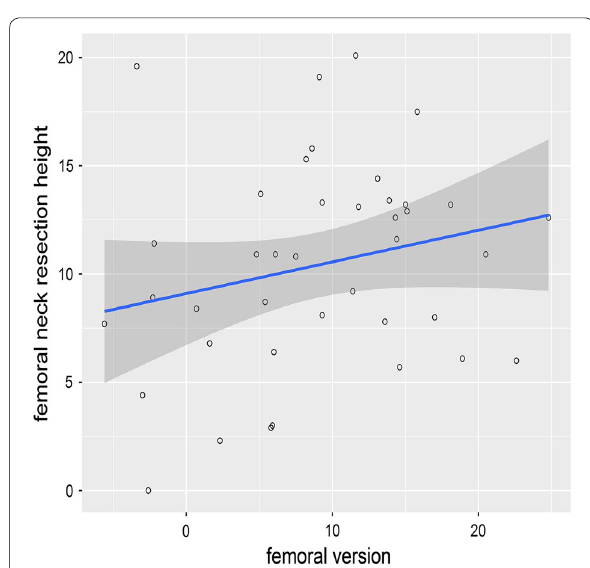
Fig. 6 The scatterplot shows the correlation between femoral version and femoral neck resection height. The blue line indicates the linear regression line and the dark grey area the corresponding the 95%